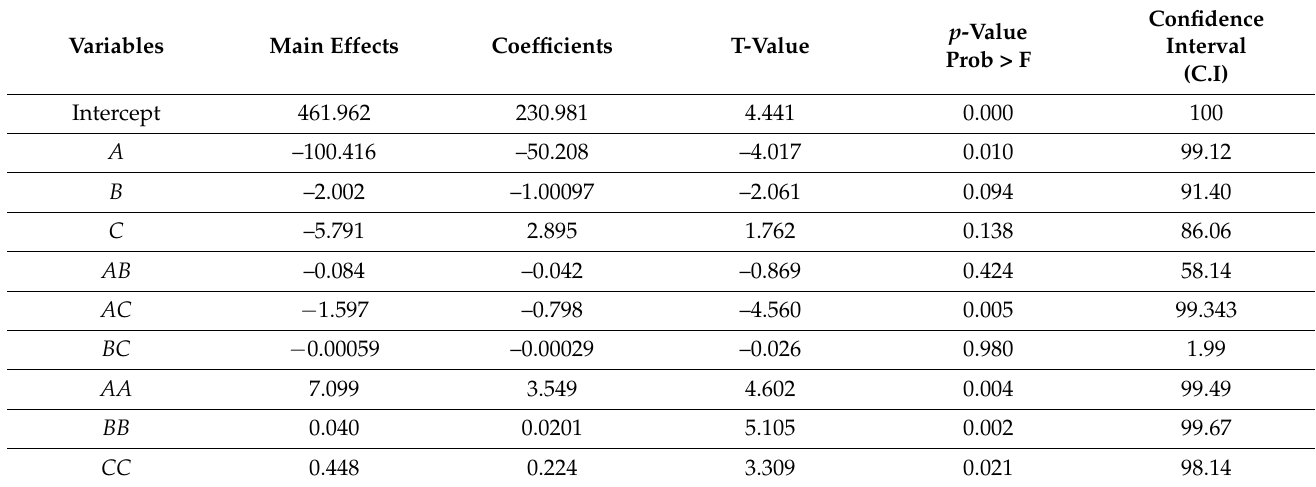
Table 3. Variables levels selected for Box–Behnken